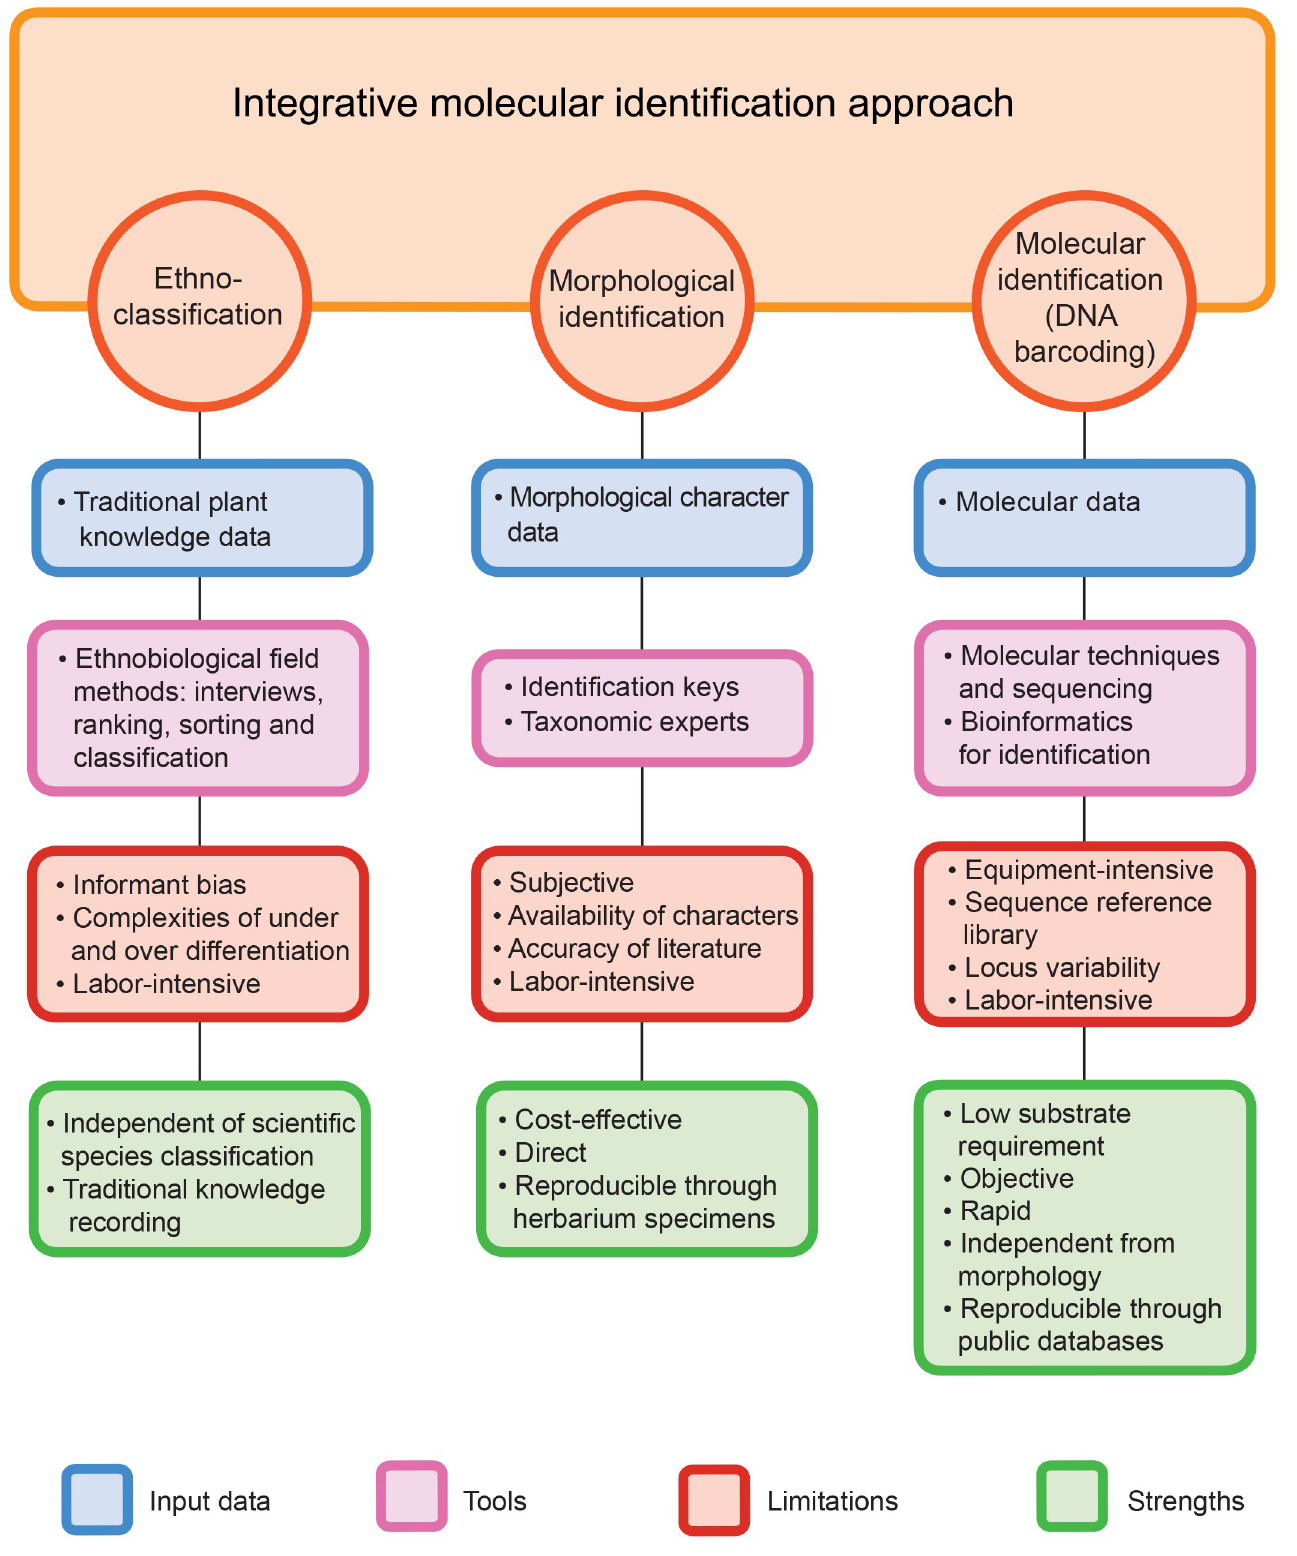
Fig 2. The strengths of DNA barcoding outweigh its weaknesses, but an integrative approach is necessary to optimize identification of unknown plant material. https://doi.org/10.1371/journal.pone.0175722.g002 PLOS ONE | https://doi.org/10.1371/journal.pone.0175722 April 18,